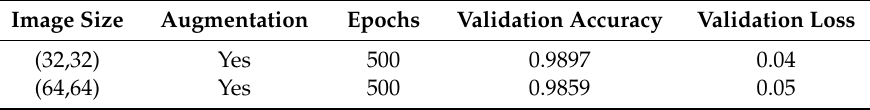
Table 3. Model performances after performing Knowledge